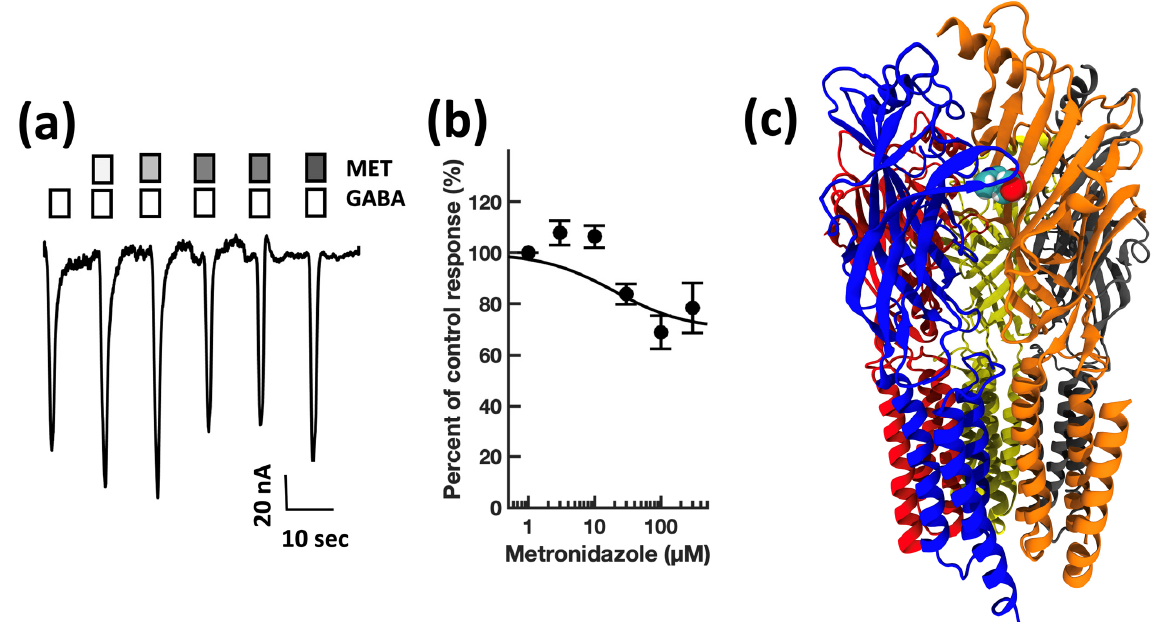
Figure 7. Metronidazole modestly inhibits GABA A receptor activation in a concentration-dependent manner, and preferentially docks at the γ+β —Interface in a pocket defined by canonical loops A-E. ( a ) Representative microfluidic ensemble whole cell recording from HEK293 cells expressing rat α 1 β 2 γ 2s GABA A receptors. Open bars above the current trace indicate the duration of GABA application. Shaded bars indicate the duration of metronidazole application. Darker shading indicates increased concentration. The concentrations applied were 3, 10, 30, 100, and 300 µ M metronidazole. Calibration bars indicate the current amplitude and duration in nA and seconds. ( b ) Metronidazole concentration response relationship for GABA receptor modulation. Each point is plotted as mean ± standard error of the mean, for 20–24 determinations. ( c ) The metronidazole binding pocket is predicted to be defined by the β (loops D, E, and F) and γ (Loops B and C) subunits. Color key: α subunit (red and grey), β subunit (yellow and orange), γ subunit (blue).